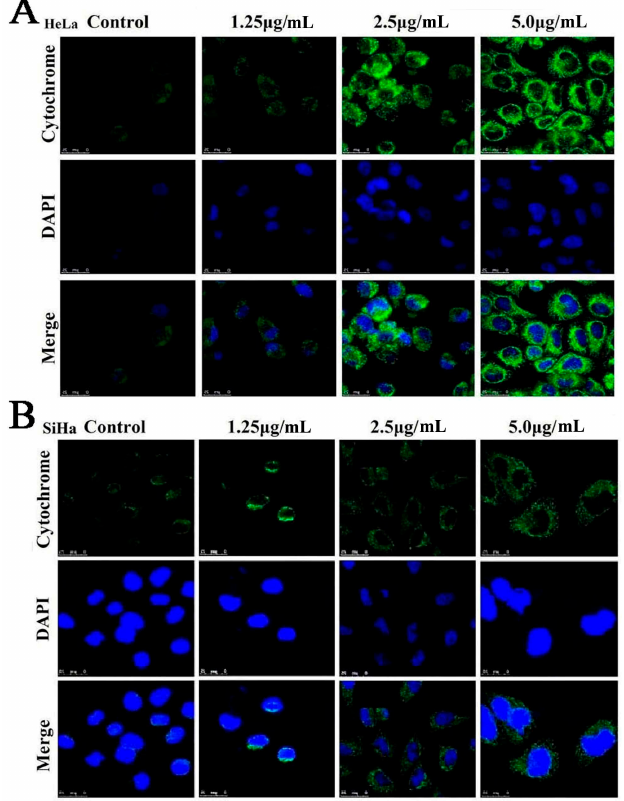
Figure 7. ( A ) Effects of dioscin on cytochrome C release in Hela cells (800×, final magnification); ( B ) Effects of dioscin on cytochrome C release in SiHa cells (800×, final magnification).